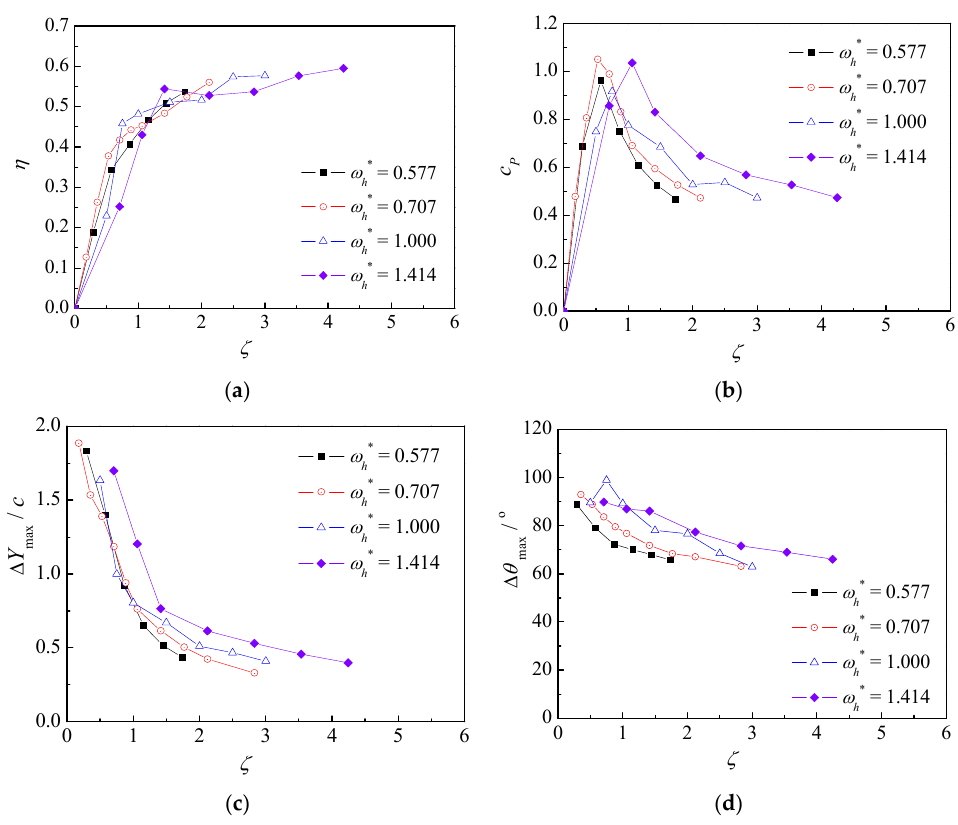
Figure 16. Foil performance parameters as a function of the damping coefficient ( ζ ) for various values of the frequency ratio in heave motion ω h * . ( a ) Efficiency η ; ( b ) power coefficient c p ; ( c ) heave amplitude Δ Y max / c ; ( d ) pitch amplitude Δθ max .